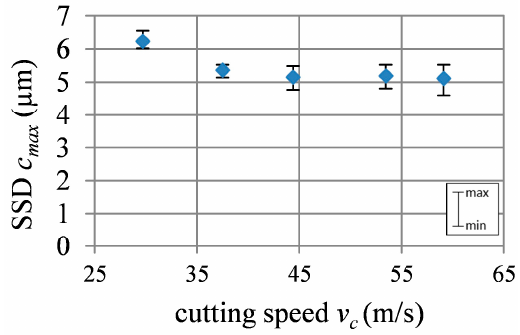
Figure 7. Maximum crack depth depending on the cutting speed.